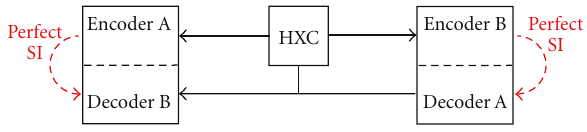
Figure 2: 2-WRC with HXC and perfect Side